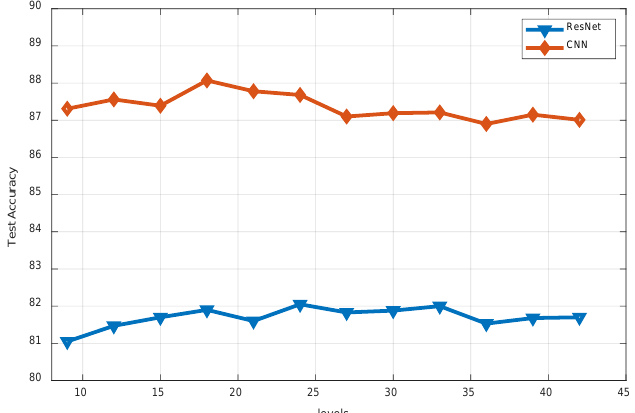
Figure 7. Performance comparison of ResNet under different levels.